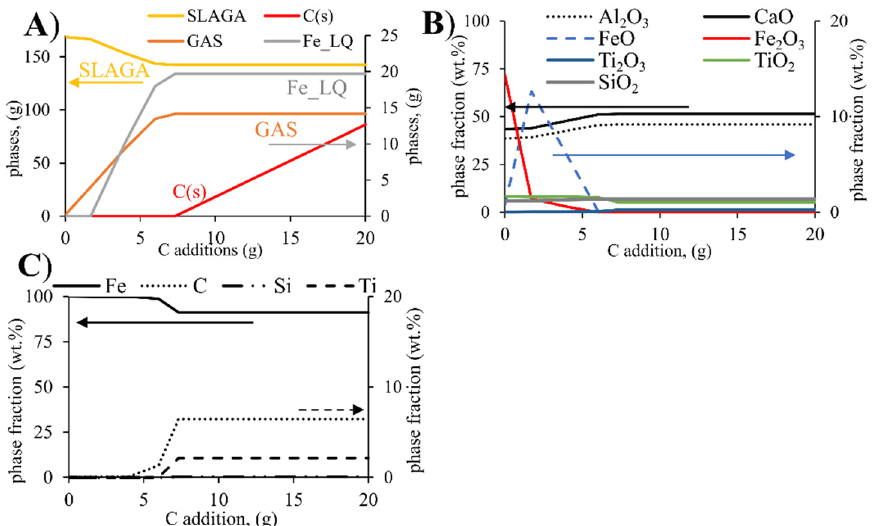
Figure 4. Equilibrium calculations at the smelting temperature ( A ) occurrence of different phases with varying C addition; ( B ) slag composition with varying C addition; and ( C ) metal composition with varying C addition. Secondary vertical axis ( x -axis) displays the species with lower concentration than the major components.